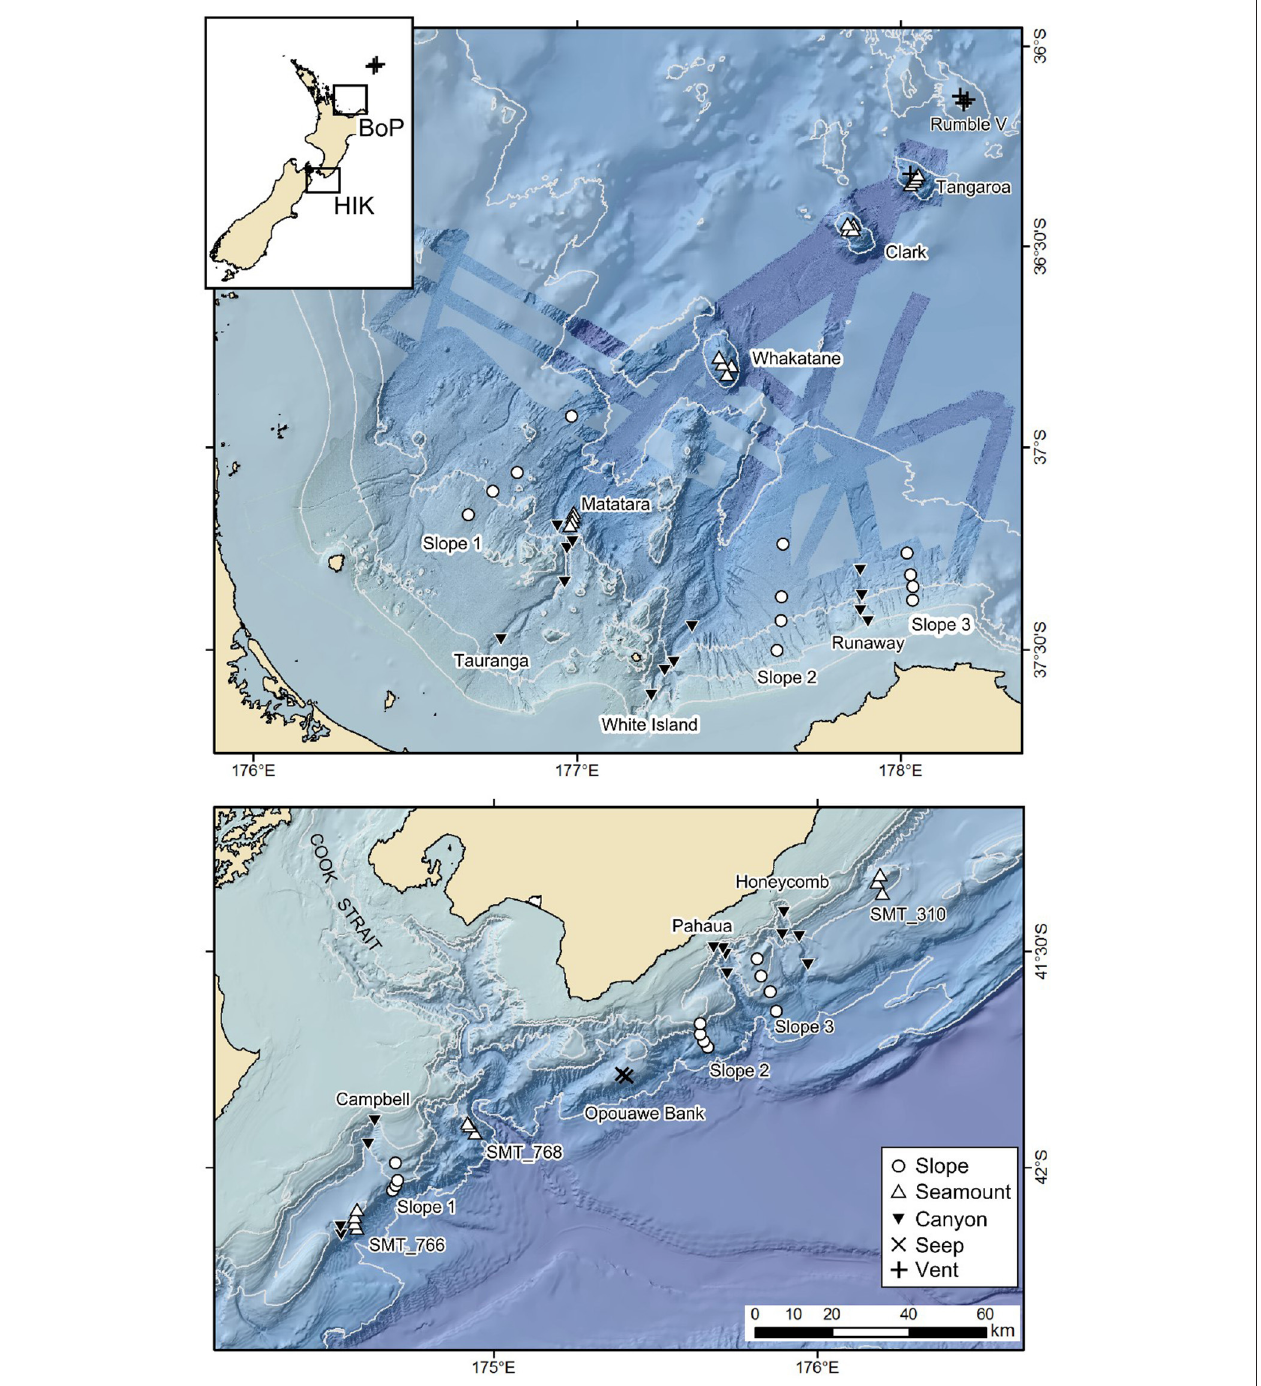
FIGURE 1 | Sampling sites at habitats in the Bay of Plenty (BOP, top) and Hikurangi Margin (HIK, bottom) study regions, and their relative locations off New Zealand (insert; crosses on insert shows location of vent sites at Healy and Brothers seamounts on the Kermadec volcanic arc). Isobaths show 200, 500, 1000, and 2000m depths. Scale bar applies to both regional maps. See Appendix 1 for sample station details.